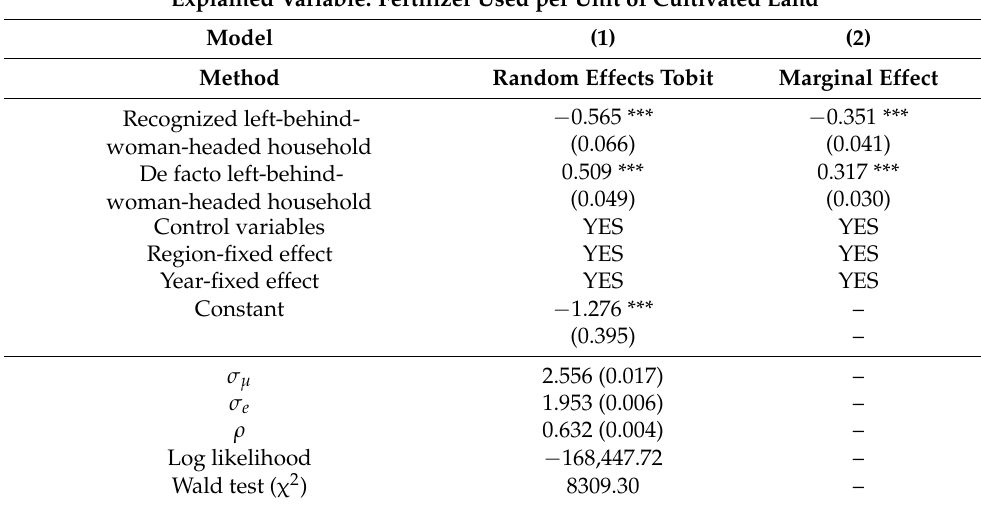
Table 1. Average impacts of left-behind women on fertilizer use. Explained Variable: Fertilizer Used per Unit of Cultivated